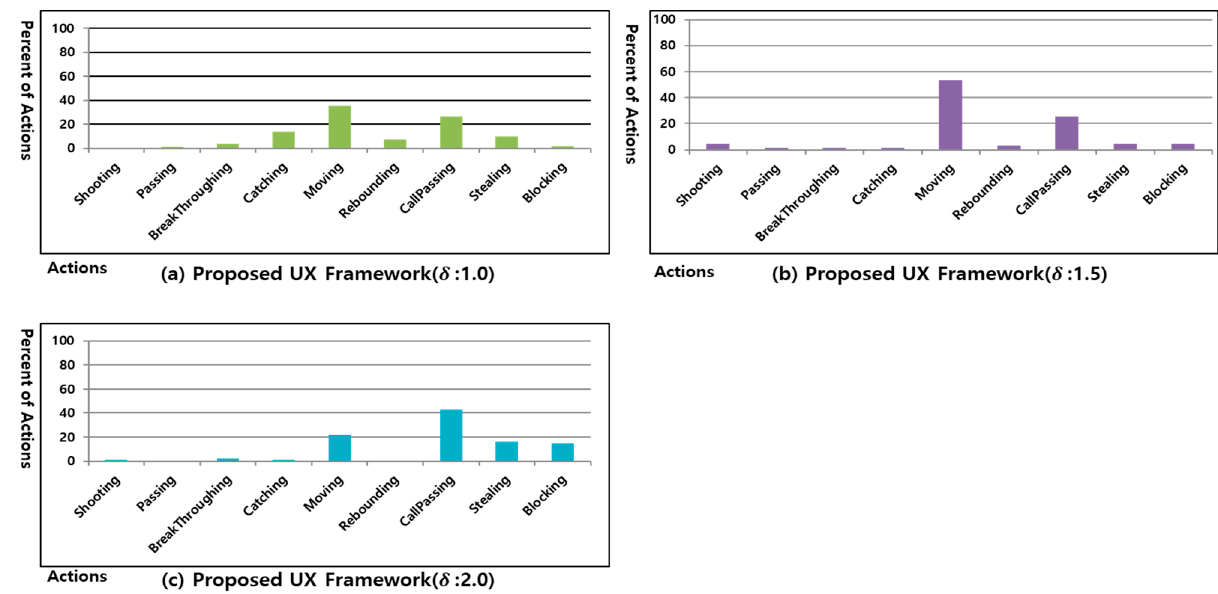
Figure 8. Percentage of actions of proposed UX framework in Freestyle game of user #1.